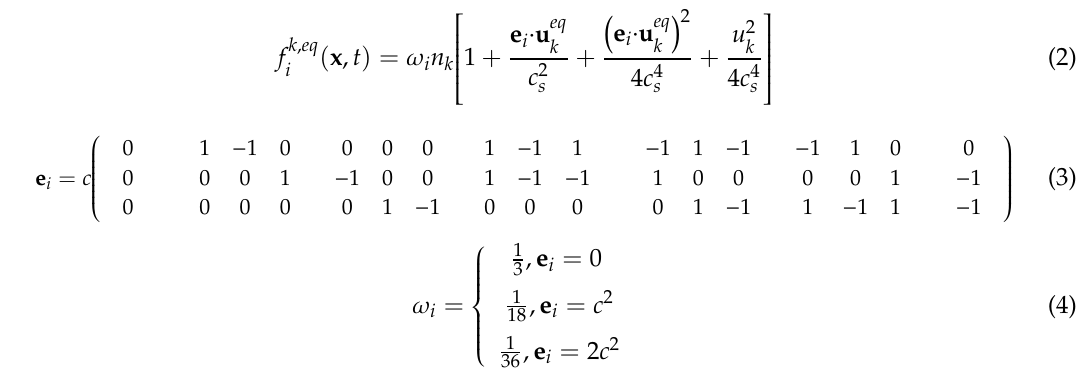
Figure 2. ( a ) Raw section image of the metal foam structure. ( b ) 3D reconstruction of a part of the foam sample of 3.6 × 3.6 × 1.4 mm (mesh number 100 × 100 × 40 of the matrix).